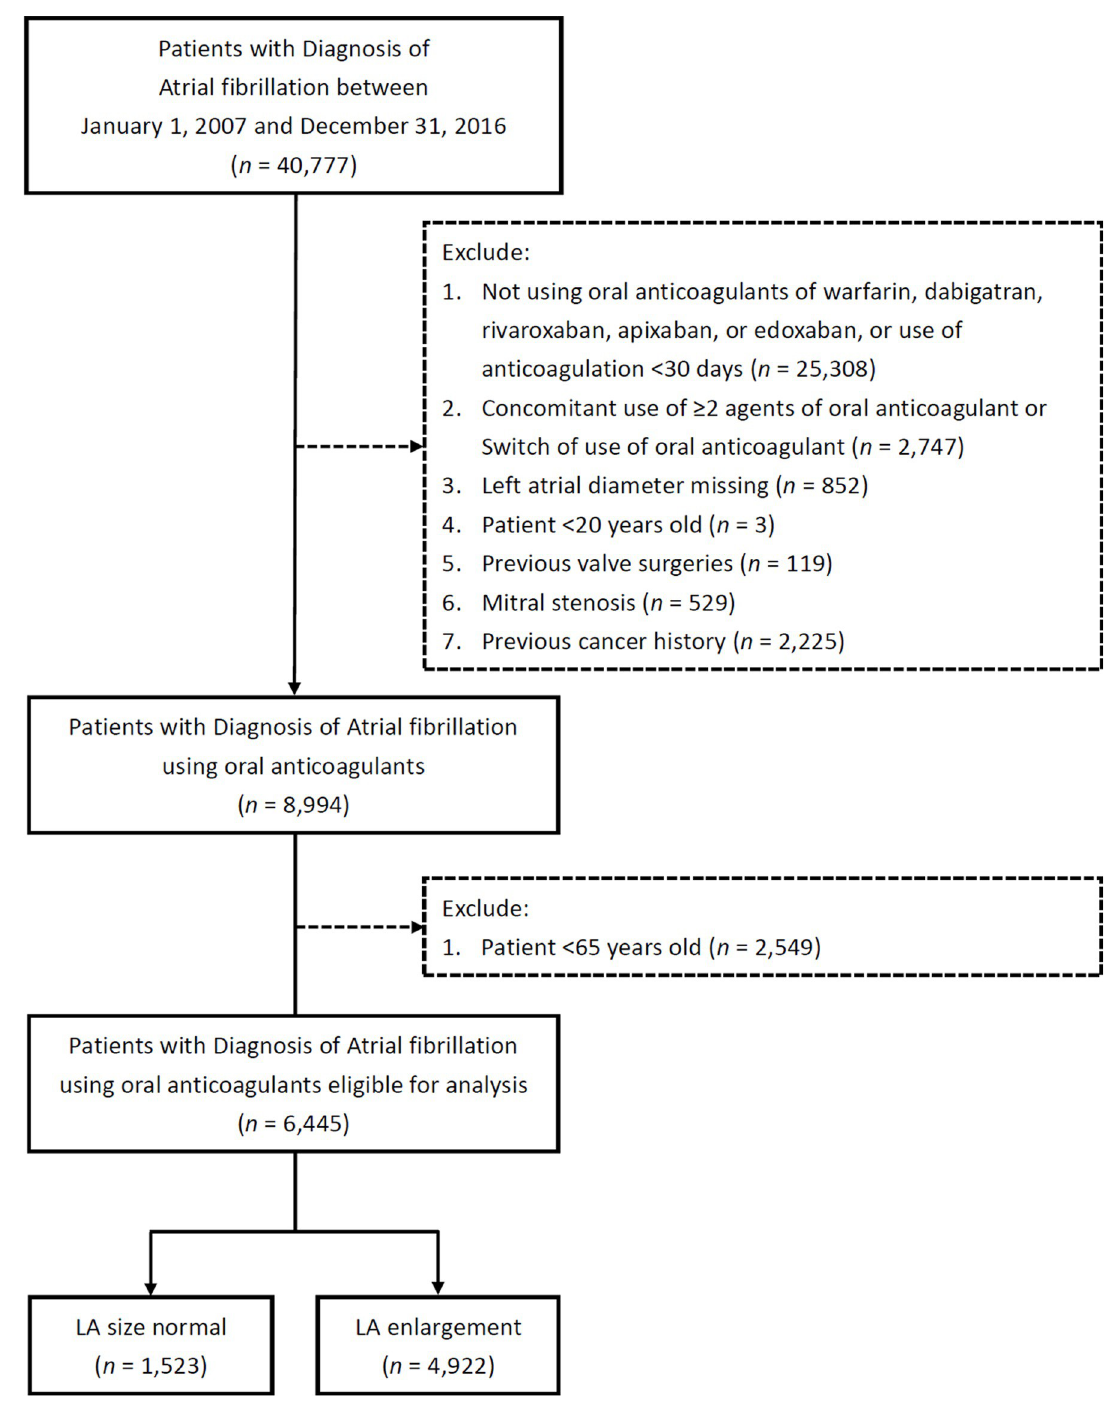
Fig 1. Study design and screening criteria flowchart for the inclusion of elderly AF patients with LAE. AF, atrial fibrillation; LA, left atrial enlargement. In the second sensitivity analysis, a LAD index > 26 mm/m 2 was considered dilated. After excluding patients with missing BSA data, data from 1,430 patients were analyzed (NOAC